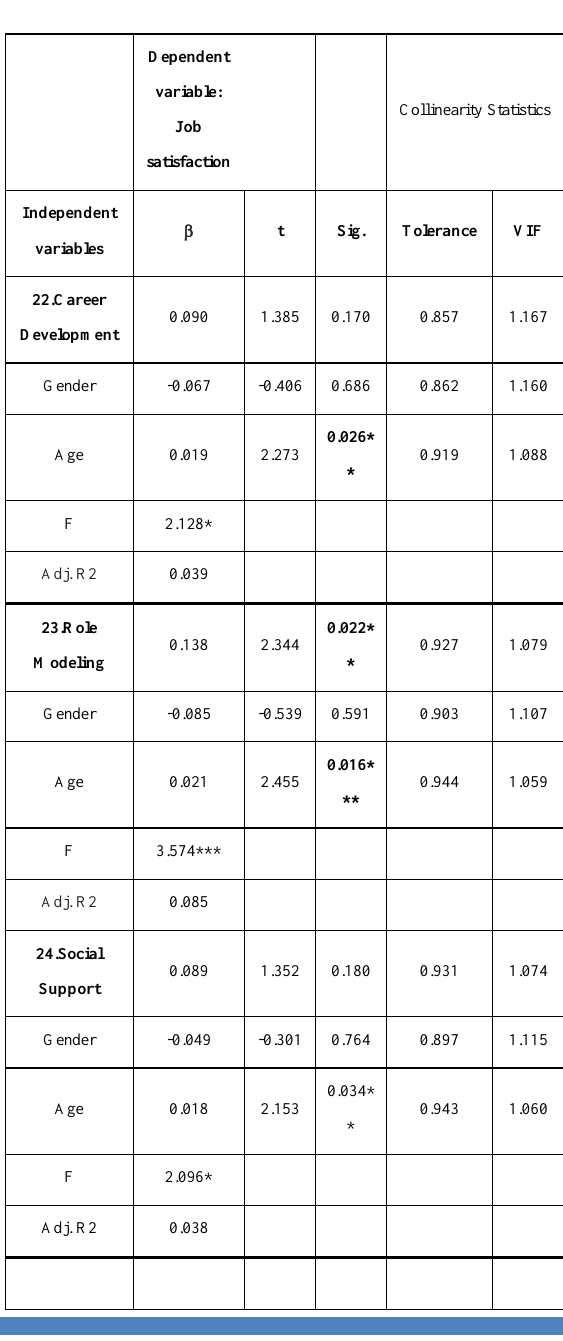
Table 11.The Effect of Mentoring